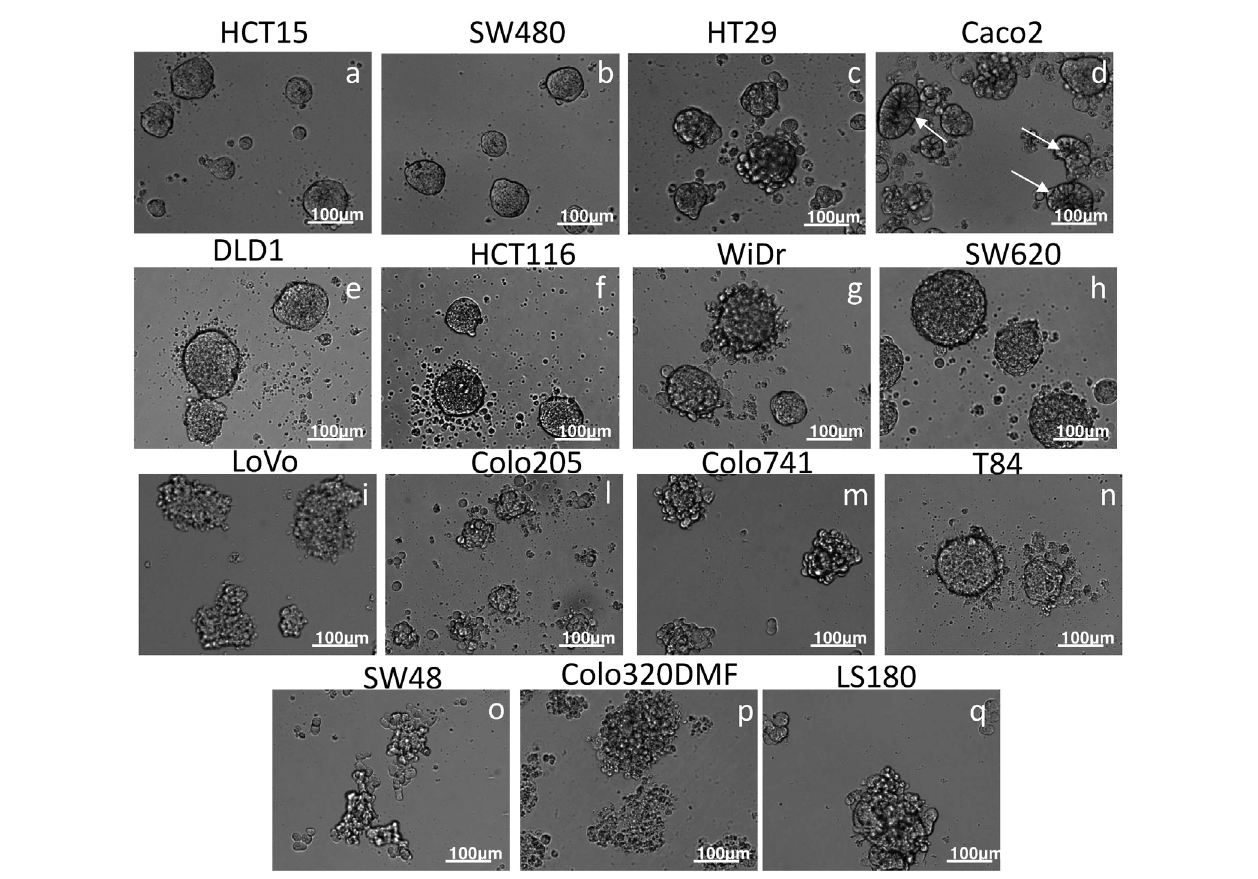
FIGURe 1 | Generation of CRC spheroids. The indicated CRC cell lines were cultured in serum free medium supplemented with 10 ng/ml of epithelial growth factor in very low adherent 96-well flat-bottomed microplates and analyzed on day 6 by inverted IX70 microscope (Olympus); images were taken with 20 × objective NA 0.40 (200 × magnification). Bar in each panel: 100 µm. Some spheroids were characterized by a spherical-like appearance with smooth surface (a,b,e,f,h,n) , others displayed rough surface (c,d,g,i–m) . In some instances (HT29, Colo205, Colo741, and T84), on the outer surface or next to the spheroid single cells are present. SW48, Colo320DMF, and LS180 (o–q) formed unshaped cell aggregates. In the case of Caco2, cell line the central portion of the spheroid appeared darker (arrows) than the peripheral region, suggesting a crypt-like